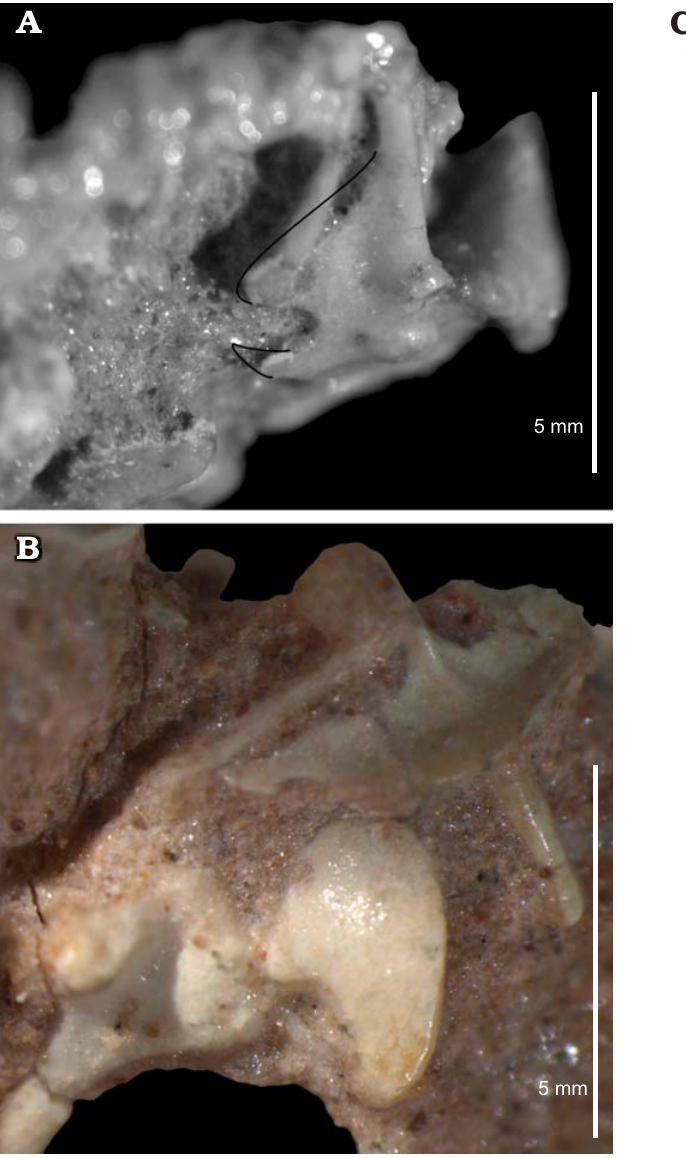
Fig. 4. Pectoral girdle of the stem-amphisbaenid Slavoia darevskii Sulimski, 1984 from late Campanian of Mongolia. A . ZPAL MgR-III/76, scapula- coracoid in anterior view; the black line marks missing parts seen in other specimens. B . ZPAL MgR-I/8, pectoral girdle with ventral edge of clavicle, interclavicle (morphotype I), coracoids, and proximal part of humerus. C . PIN 4487/14, sternum with rib attachments, coracoids with epicoracoids, inter- clavicle (morphotype I), humerus, cervical, and skull in ventral